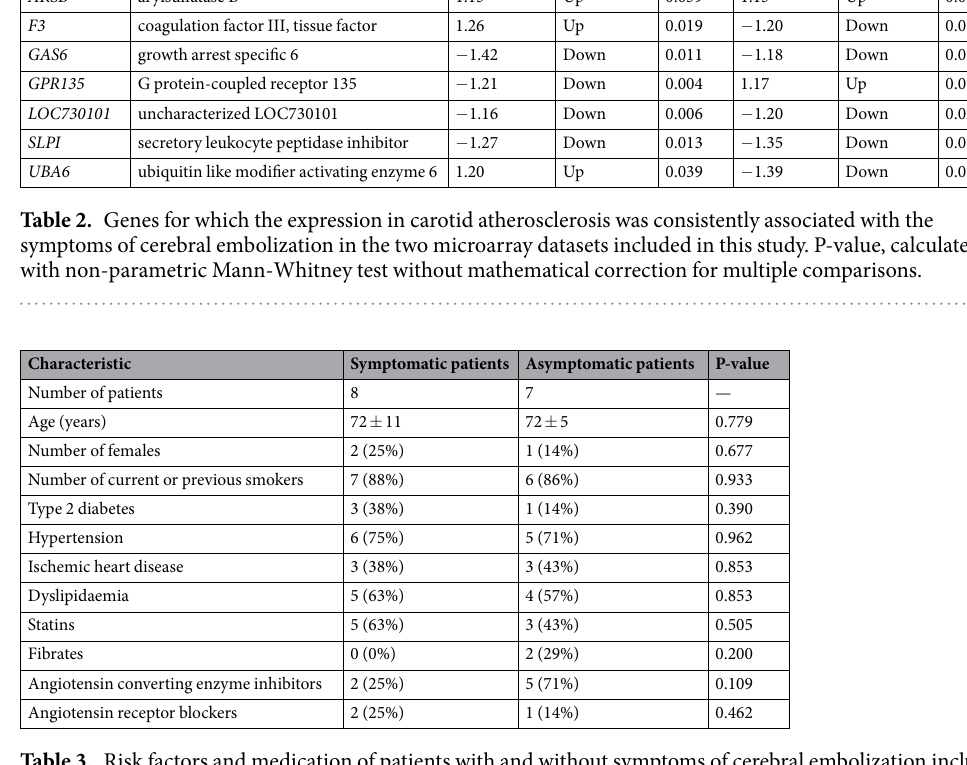
Table 3. Risk factors and medication of patients with and without symptoms of cerebral embolization included in the validation group. Nominal variables are presented as numbers; continuous variables are presented as mean ± standard deviation. Two-sided P value calculated by Mann Whitney U test (continuous variables) or Fisher’s exact test (nominal